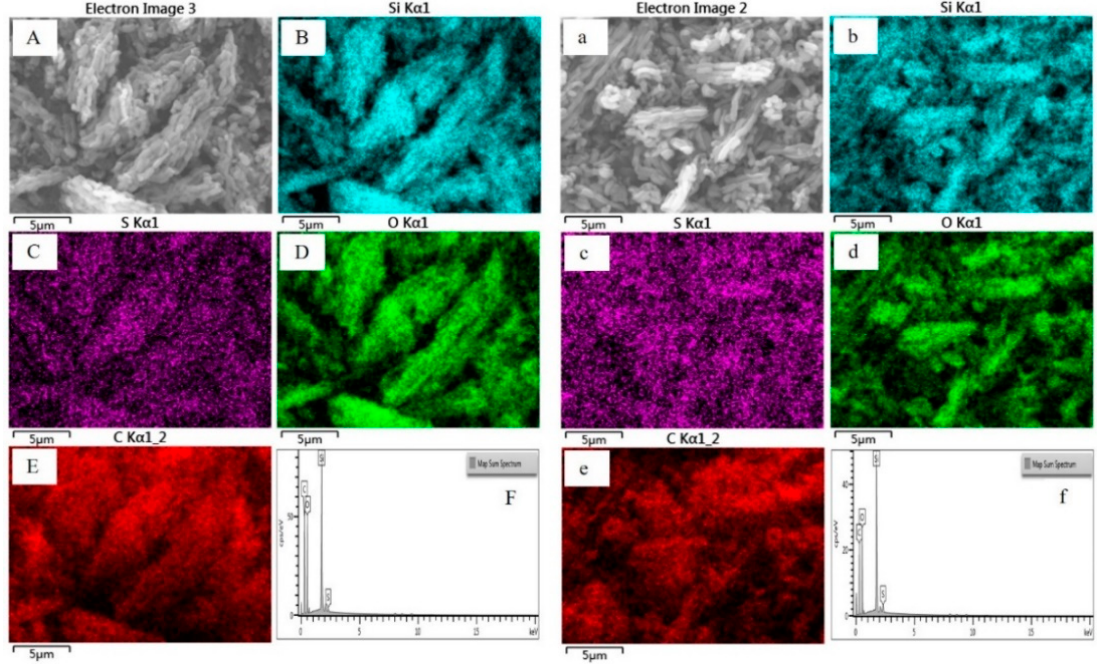
Figure 4. SEM images ( A and a ), silicon ( B and b ), sulfur ( C and c ), oxygen ( D and d ), carbon ( E and e ) elemental mappings and EDX analyses ( F and f ) of meso ‐ Pr ‐ SO 3 H ‐ SBA ‐ 15 ( A – F ) and meso ‐ Ph ‐ SO 3 H ‐ SBA ‐ 15 ( a – f ) samples.